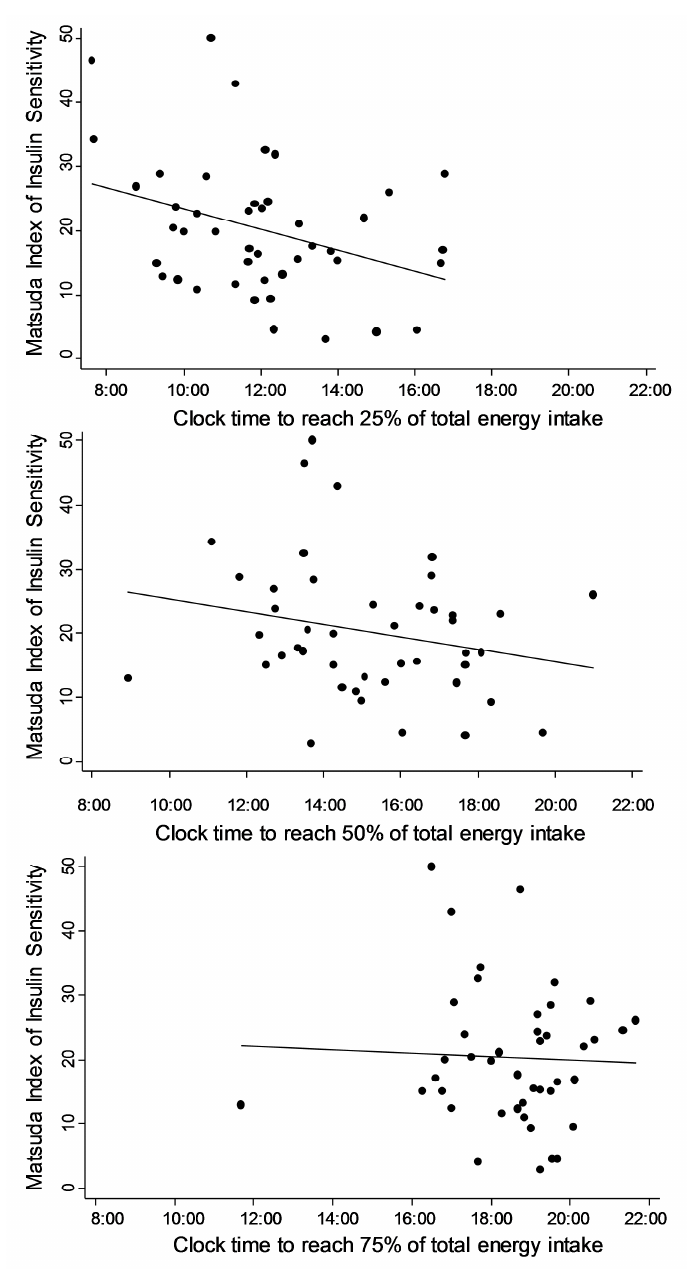
Figure 2. Associations between the Matsuda Index of insulin sensitivity and the clock time 25% of energy intake ( top panel ), 50% of energy intake ( middle panel ) and 75% of energy intake ( bottom panel ) was consumed. The unadjusted regression line is plotted. The r values represent unadjusted Pearson correlations and associated p values.